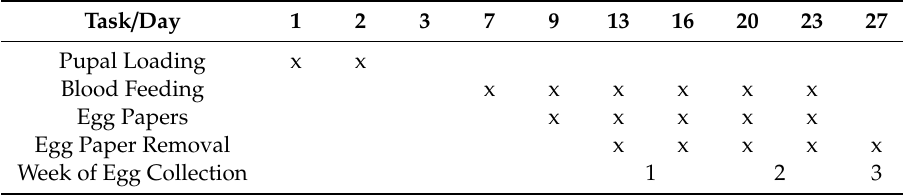
Table 1. Rearing procedures for Aedes albopictus experiments.